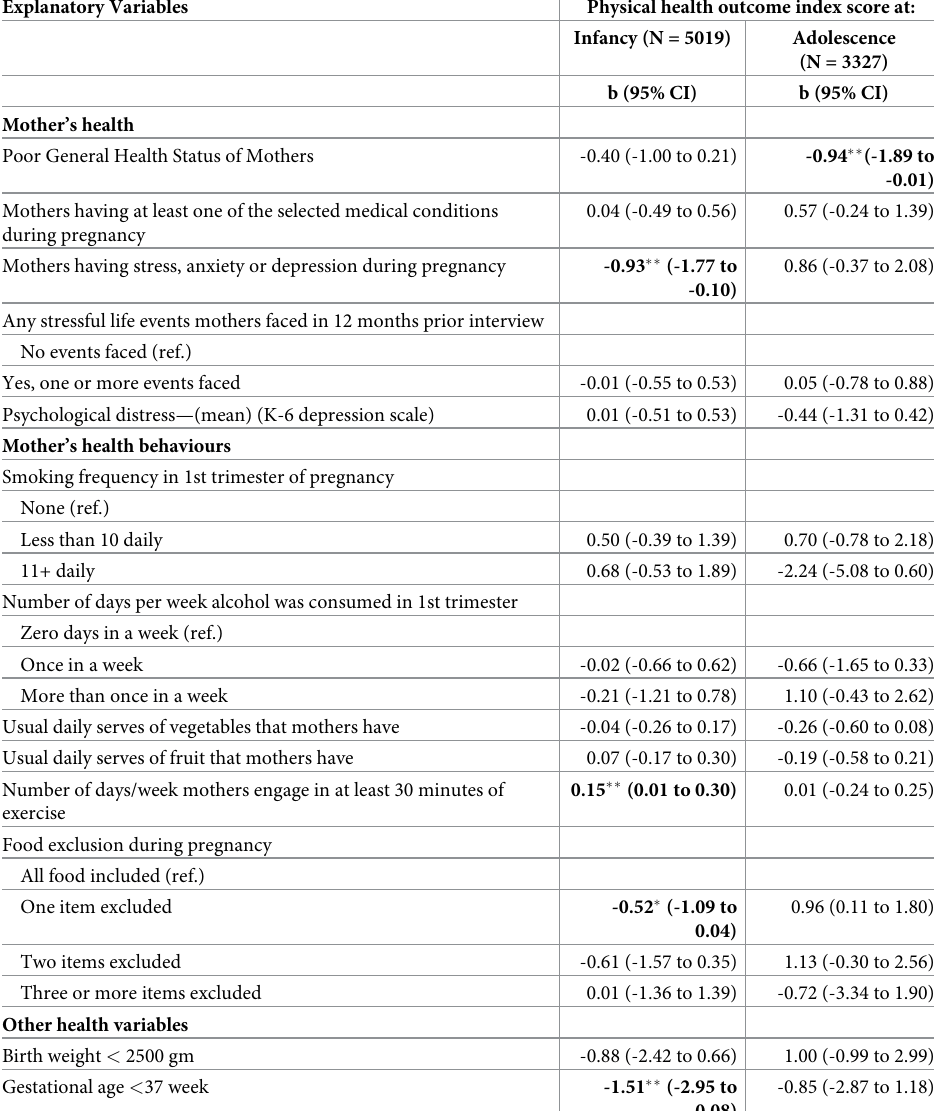
Table 4. Maternal health and health-related behaviours and their associations with children’s physical health out- come index score during infancy (0–1 year of age) and adolescence (12–13 years of age). Explanatory Variables Physical health outcome index score